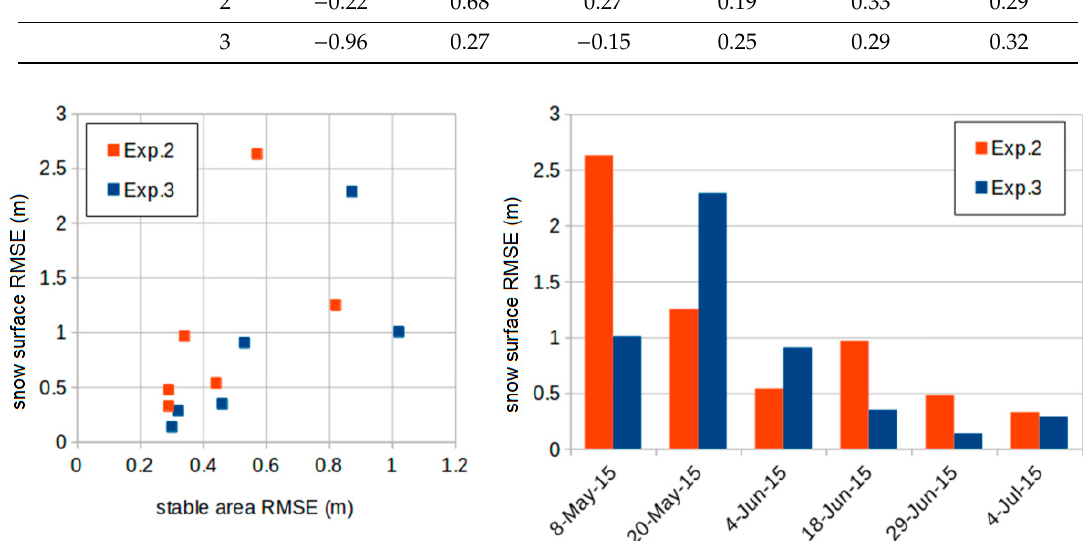
Figure 7. ( Left ) scatterplot of the RMSE (root mean square error) of the elevation on the stable areas (snow-free) and the RMSE on the snow surface, ( Right ) evolution of the RMSE on the snow surface with time.